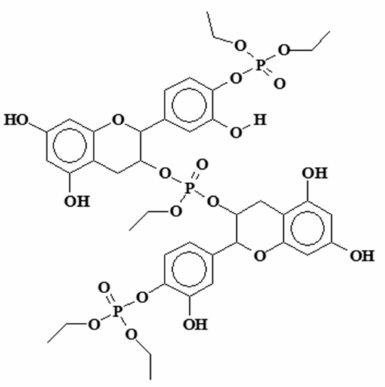
Figure 9. Example of cross-linking product of a flavonoid tannin by reaction with triethyl phosphate [109].